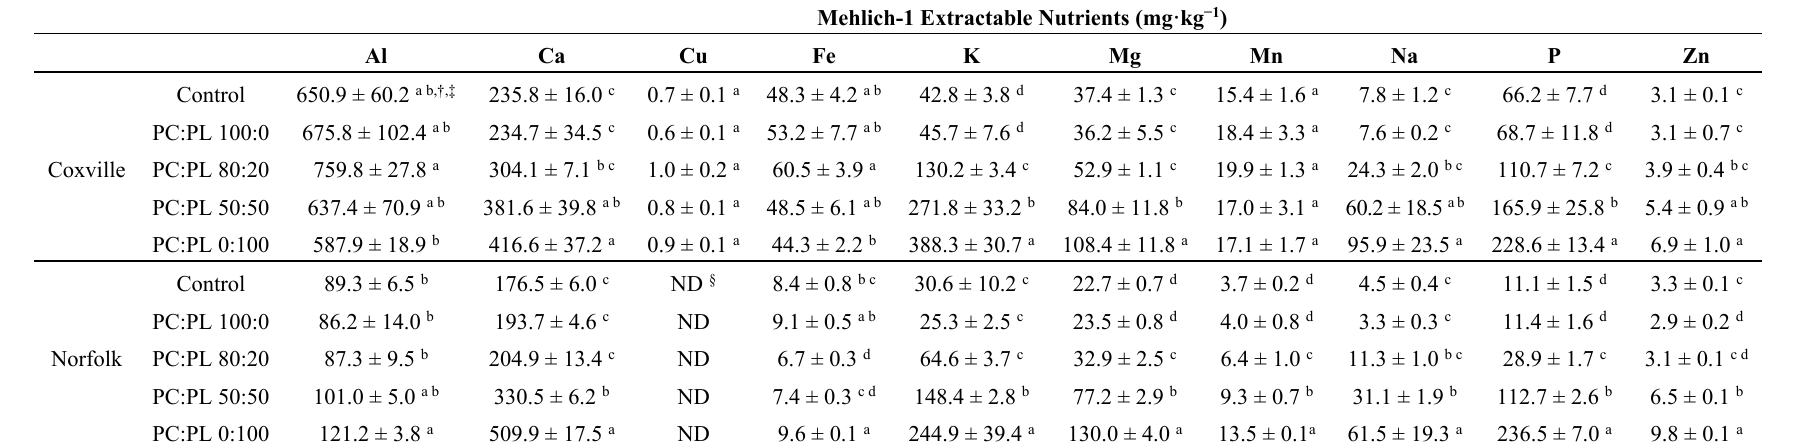
Table 2. Mehlich-1 extractable nutrients after 78 days